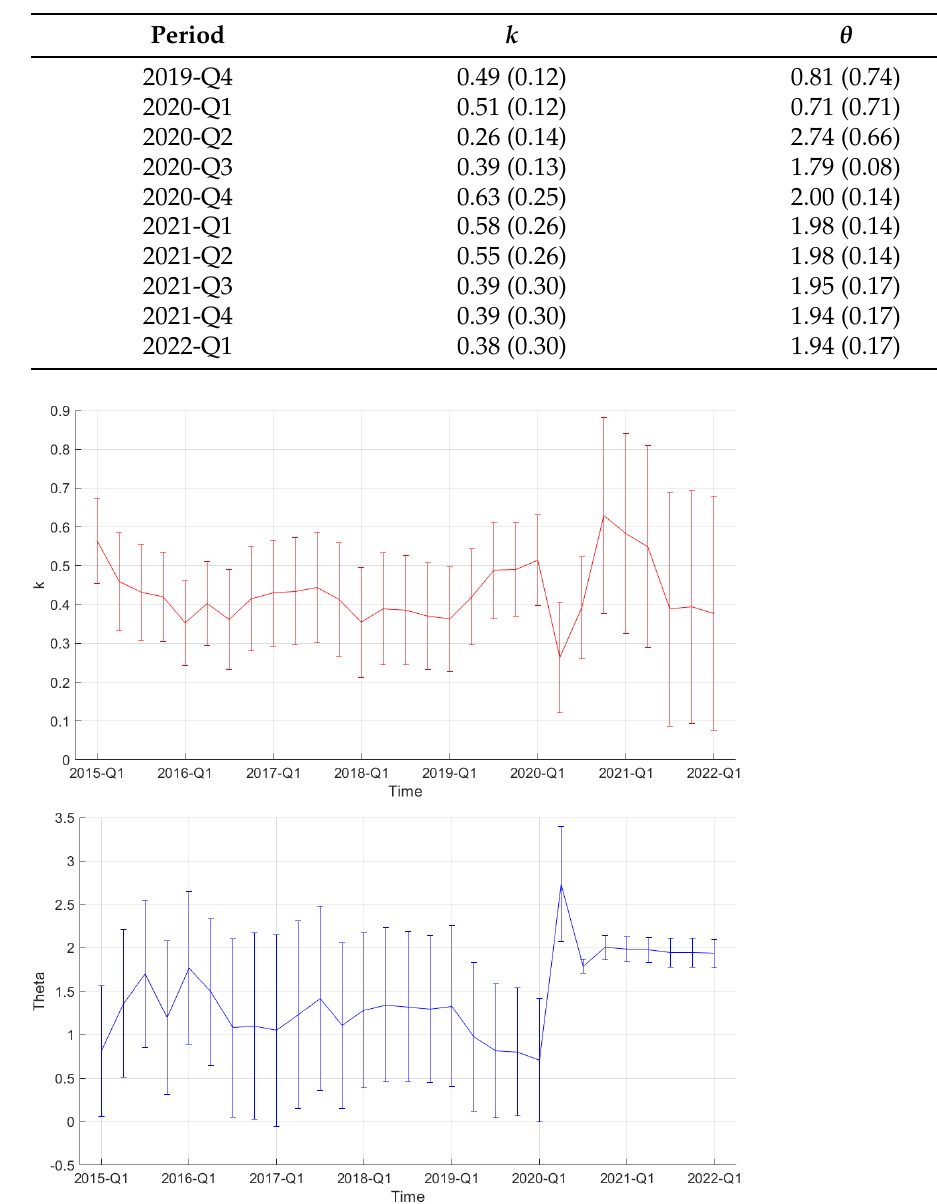
Table 2. Estimated values, with standard deviations in brackets, of the parameters k and θ in (34) by the OLS method with a 16-quarter running window.